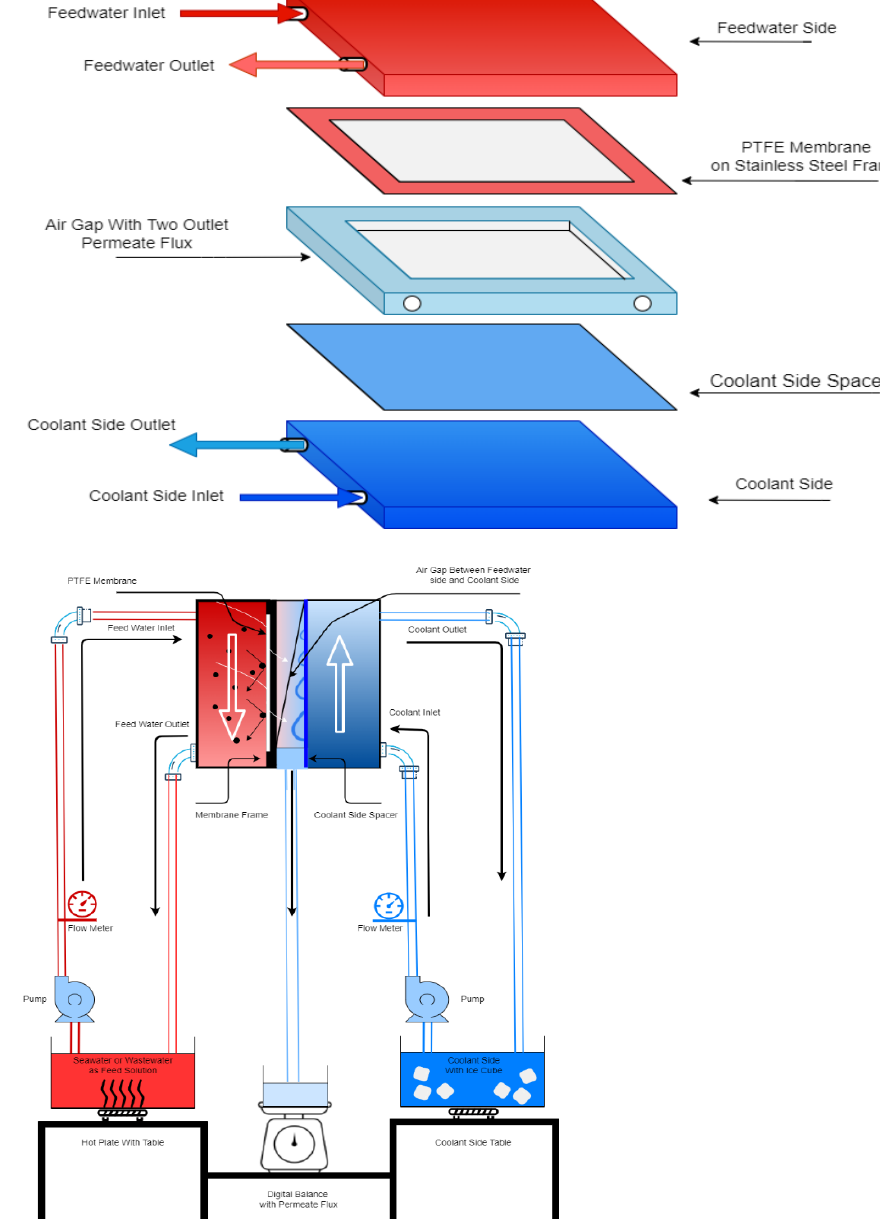
Figure 1. Schematic diagram of the AGMD unit.